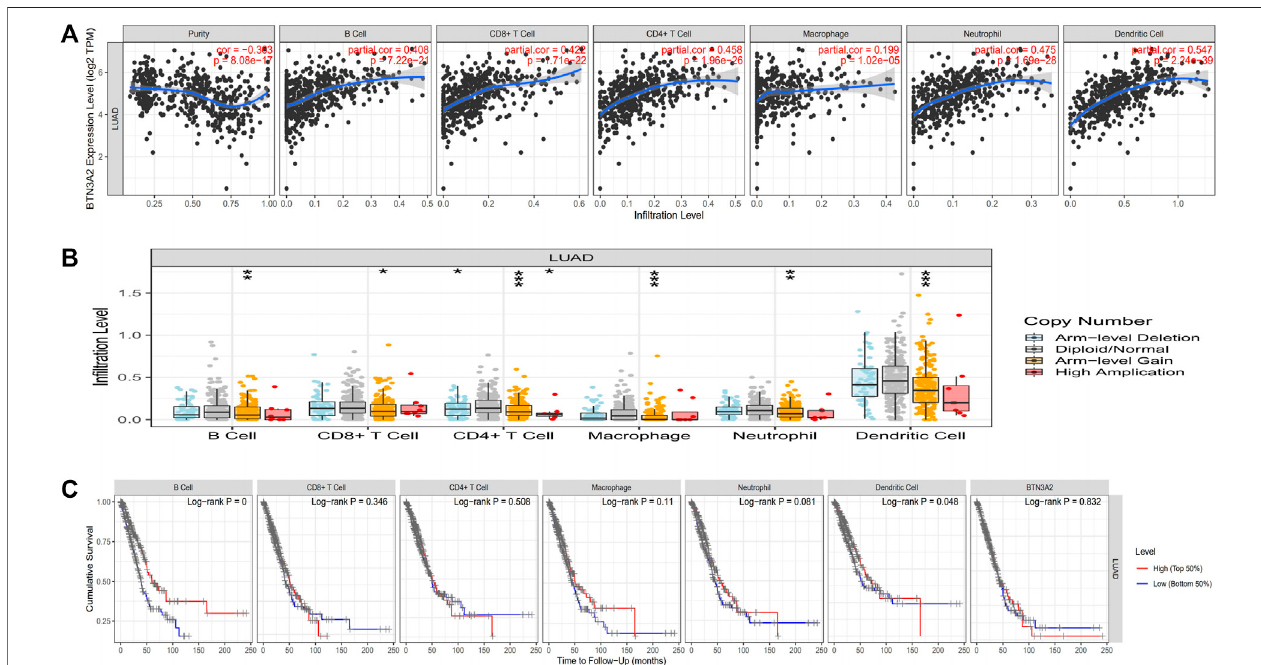
FIGURE 5 | Expression of BTN3A2 in LUAD was linked to immune invasion. (A) BTN3A2 expression has positive correlations with the in fi ltration levels of purity, Bcells,neutrophils,CD8+Tcells,dendriticcells,CD4+Tcells,andmacrophagesinLUAD. (B) BTN3A2CNVin fl uencesthein fi ltrationlevelofBcells,CD8+Tcells,CD4+ T cells, macrophages, neutrophils, and dendritic cells in LUAD. (C) Kaplan – Meier plots of the relationship of immune invasion with OS of LUAD. p p < 0.05; pp p < 0.01; ppp p <